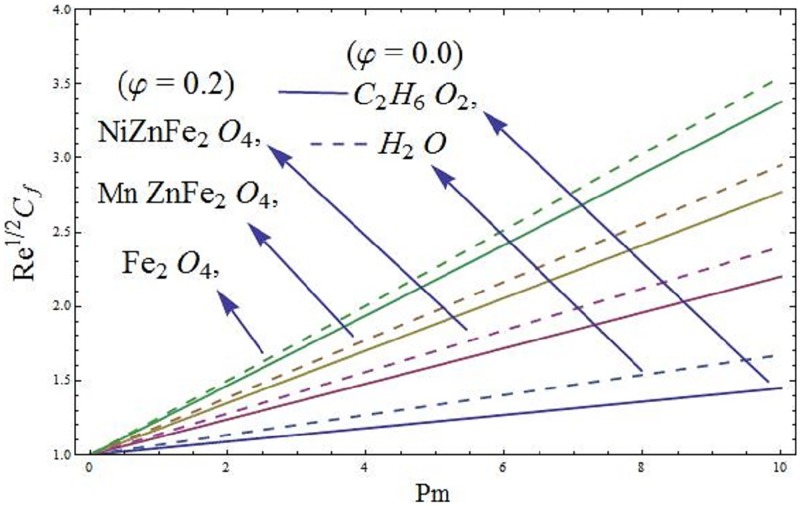
Wall shear stress versus Pm.